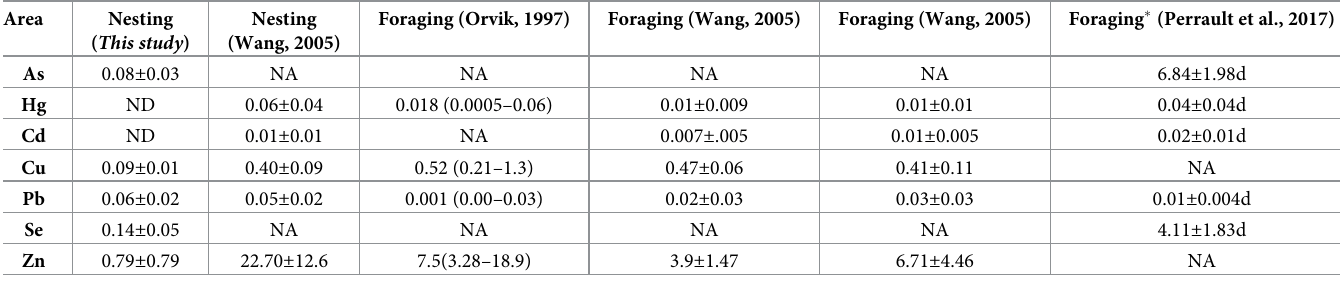
Table 2. Heavy metal concentrations reported in different areas (mean ± standar deviation, μ g g -1 wet weight) in blood of Kemp´s ridley turtles.